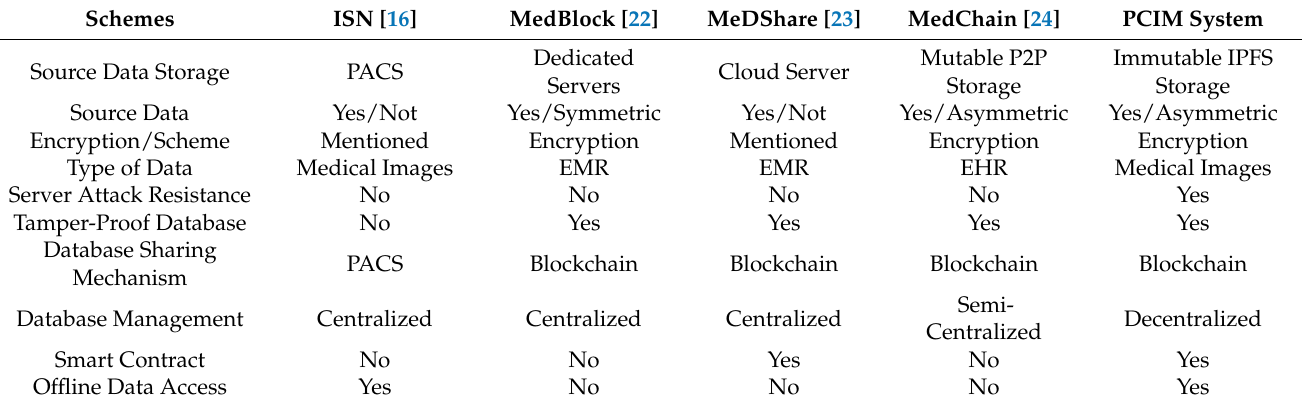
Table 2. Comparison between the Existing and Proposed PCIM